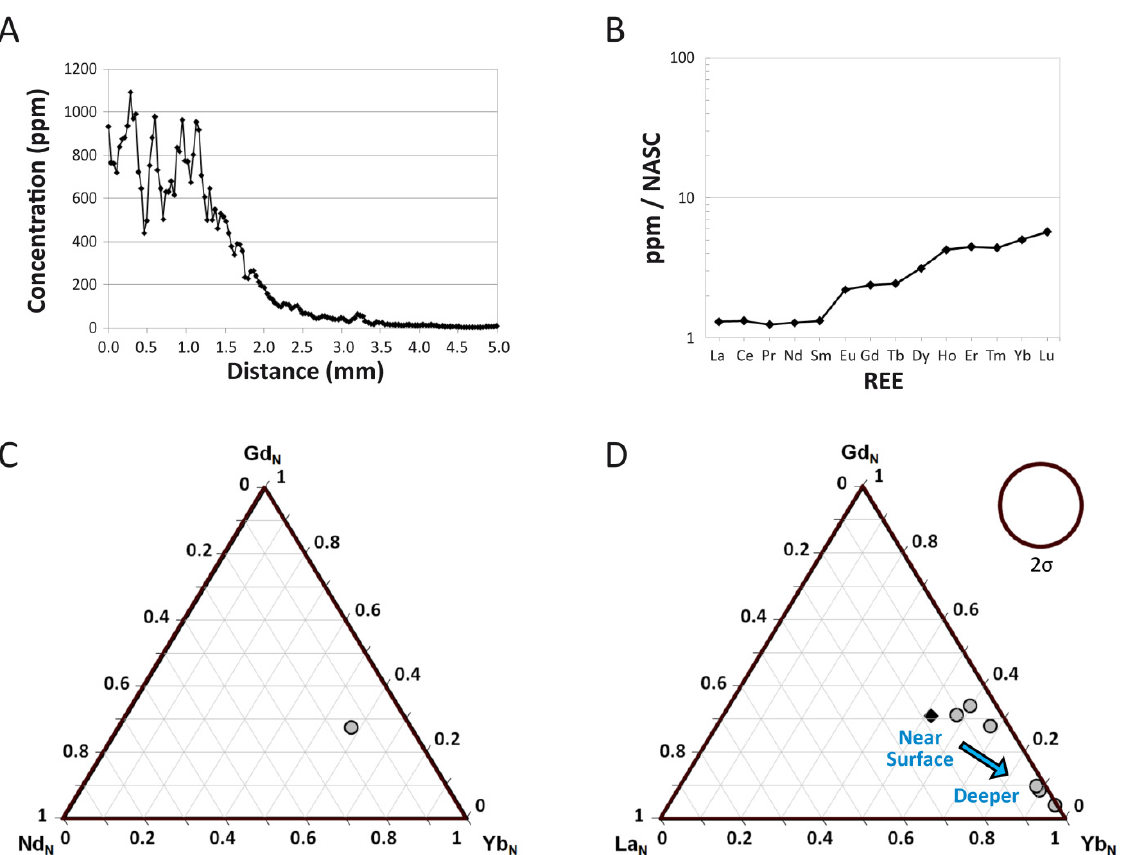
Figure 3. REE composition of the tibia of MOR 2598. ( A ) Three-point moving average profile of La concentrations in the outermost 5 mm of the bone. ( B ) Average NASC-normalized REE composition of the fossil specimen as a whole. ( C , D ) Ternary diagrams of NASC-normalized REE. ( C ) Average composition of the bone. ( D ) REE compositions divided into data from each individual laser transect (~5 mm of data each). Compositional data from the transect that included the outer bone edge is denoted by a dark diamond; all other internal transect data are indicated by gray circles. The 2 σ circle represents two standard deviations based on ± 5% relative standard deviation.